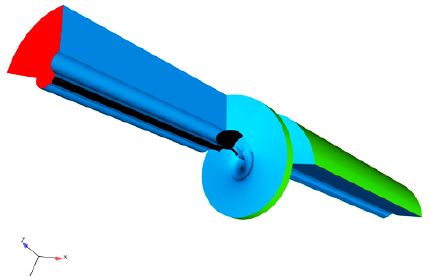
Figure 3. Perspective view of the computational domain for the PPTC. The propeller, hub, and shaft are colored with black. The inlet face is colored with red, the cyclic boundaries with blue, and the simplified tunnel wall with